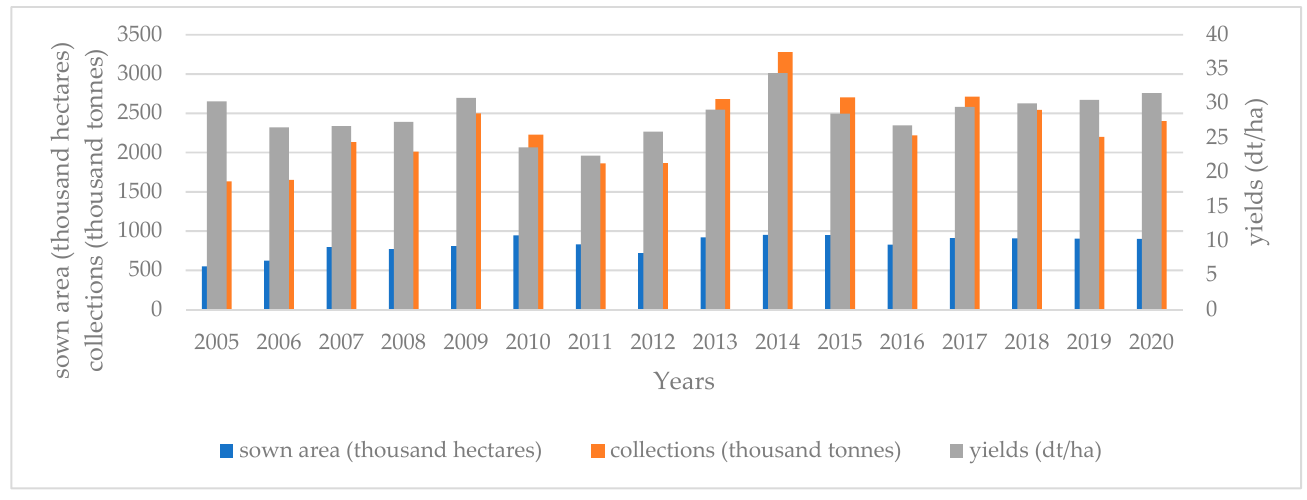
Figure 1. Sown area, yields, and collection of rapeseed in Poland. Source: own elaborations based on the rapeseed market [42].